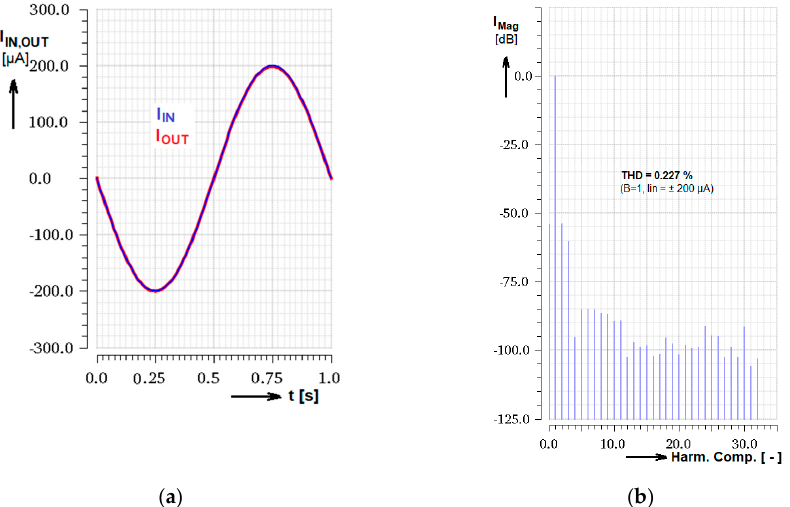
Figure 10. DFT analysis of the output harmonic current; ( a ) Input and output signal transient simulation for the gain set to B = 1; ( b ) DFT analysis expressed in dB related to the first harmonic component and appropriate THD result.